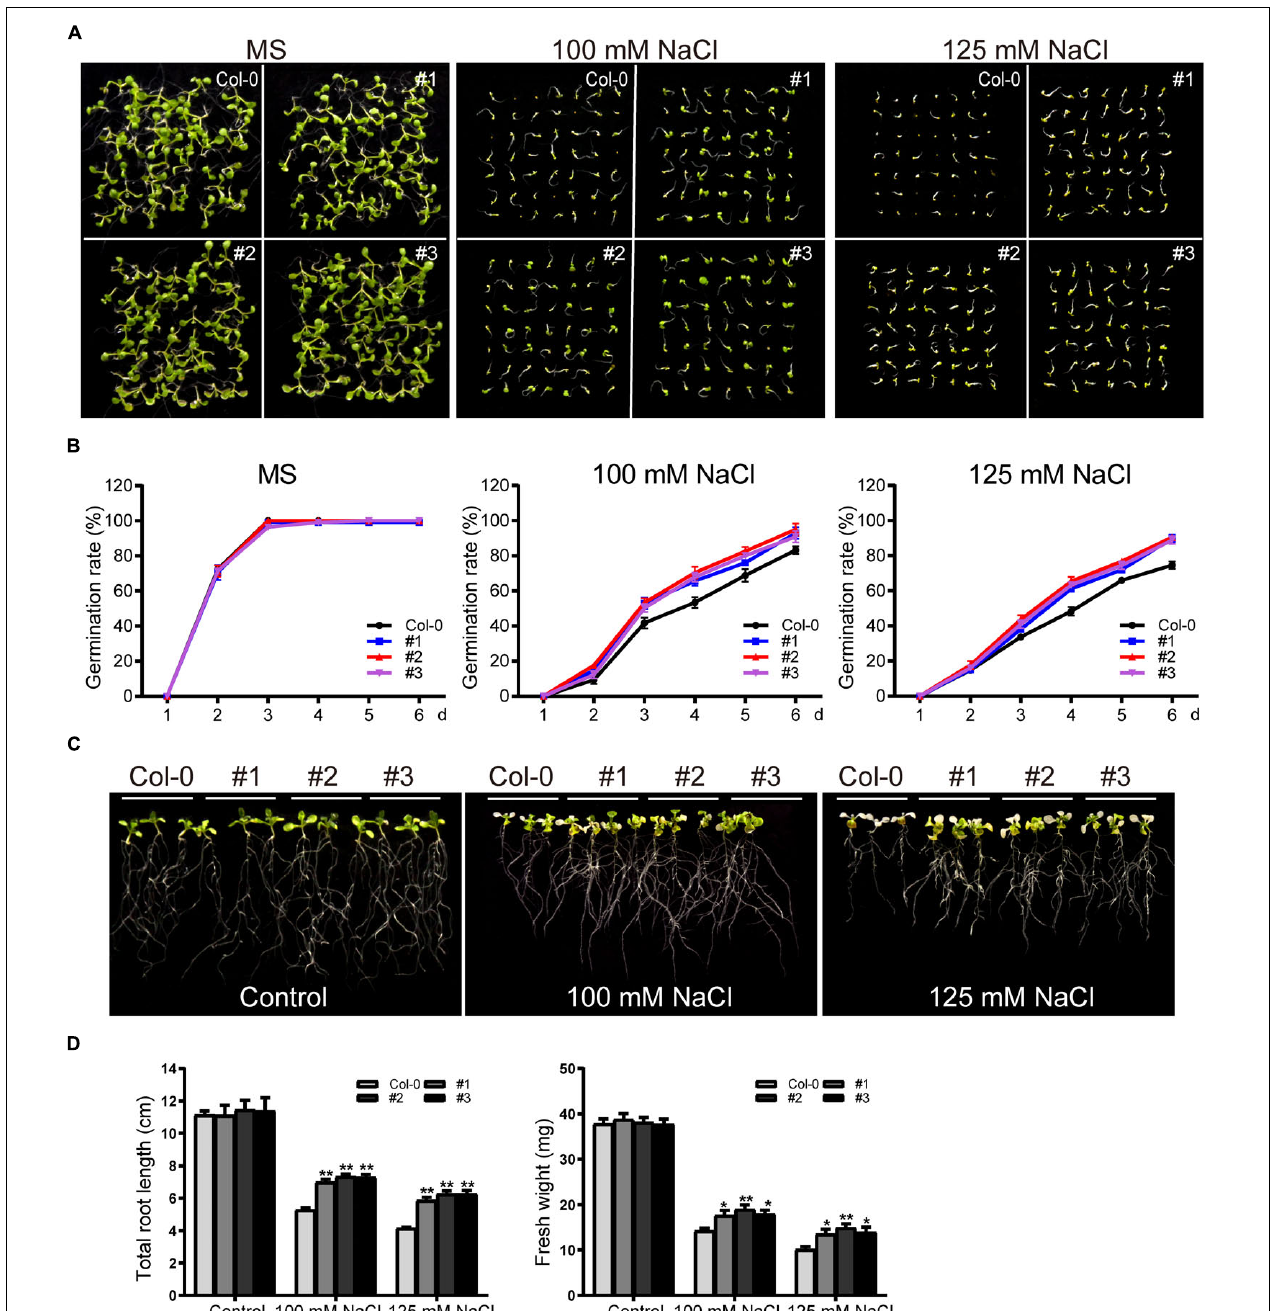
FIGURE 11 | Phenotype analysis of TaDEAD-box57-3B transgenic plants under salt treatment. (A) Seed germination assays of WT and TaDEAD-box57-3B transgenic lines. Seeds were grown on MS and MS medium supplemented with 100 mM and 125 mM NaCl. (B) The germination rates of WT and TaDEAD-box57-3B transgenic lines. The germination rate was calculated for the next 6 days. (C) Root length assays of WT and TaDEAD-box57-3B transgenic lines. Five-day-old seedlings were transferred to MS and MS medium supplemented with 100 mM and 125 mM NaCl. (D) The total root lengths and fresh weights of WT and TaDEAD-box57-3B transgenic lines. The data are shown as the means ± SD obtained from three biological replicates. ANOVA test was used to analyze significant differences (* p < 0.05, ** p <